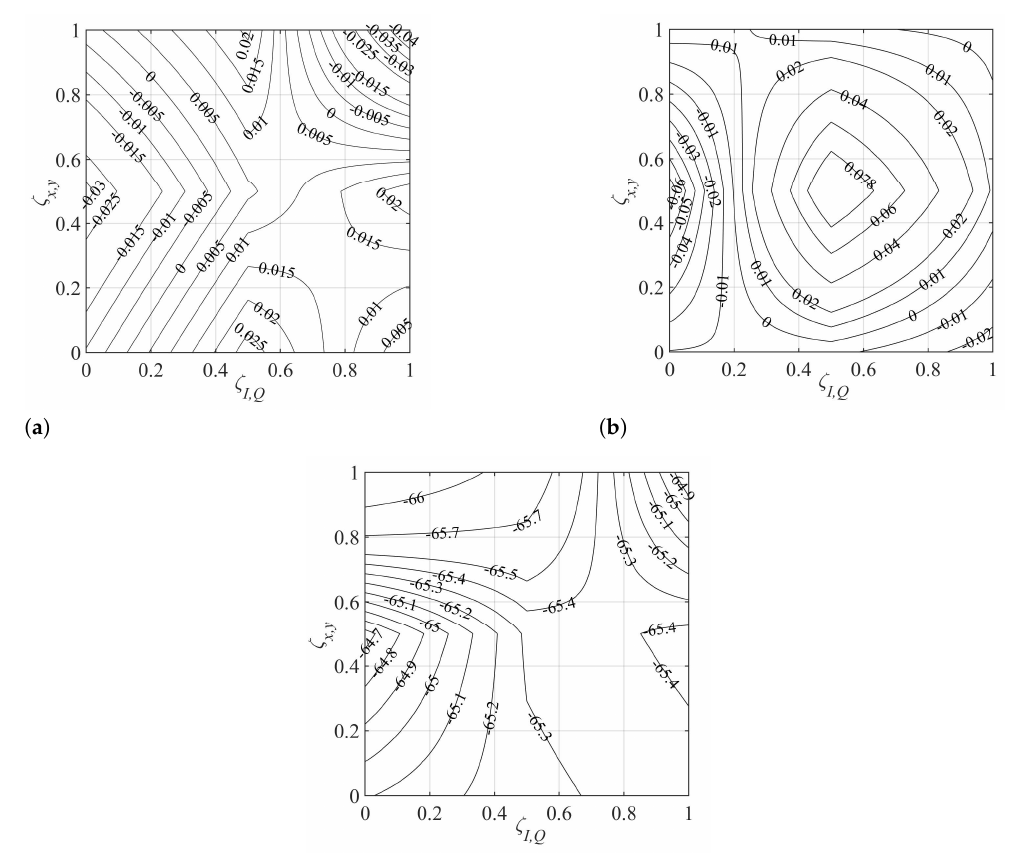
Figure 3. ( a ) Normalized mean of the I component of the ICXT field in the x direction at the interfered core output; ( b ) correlation coefficient between the I component of the ICXT field in the x direction and the Q component of the ICXT field in the y direction at the interfered core output; and ( c ) mean power of the I component of the ICXT field in the x direction at the interfered core output (in dB)